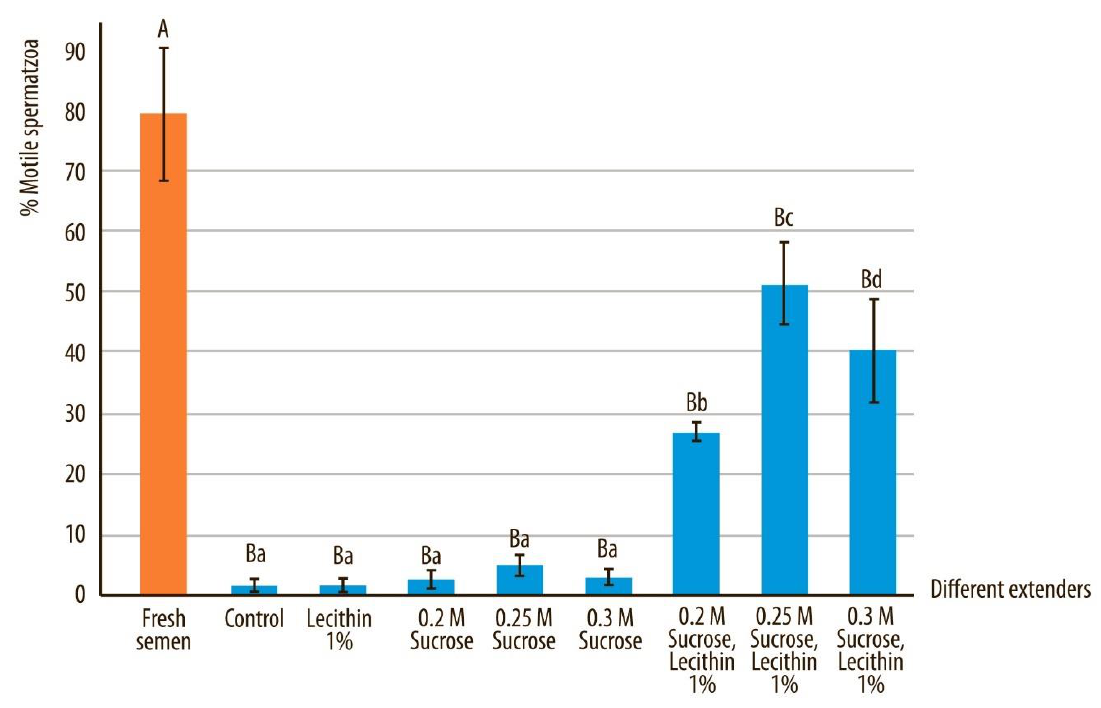
Figure 2. Total motility in canine sperm after devitrification regarding the vitrification media. Data are expressed as mean ± SD.